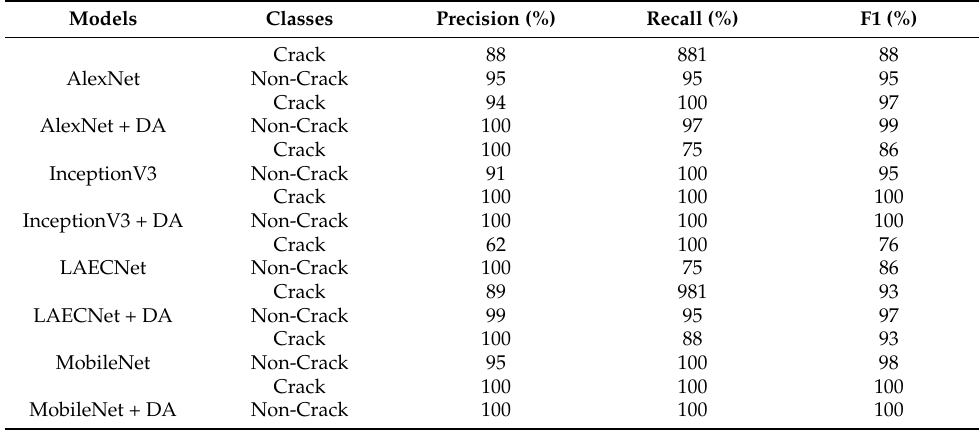
Table 5. Classification results for each class type.